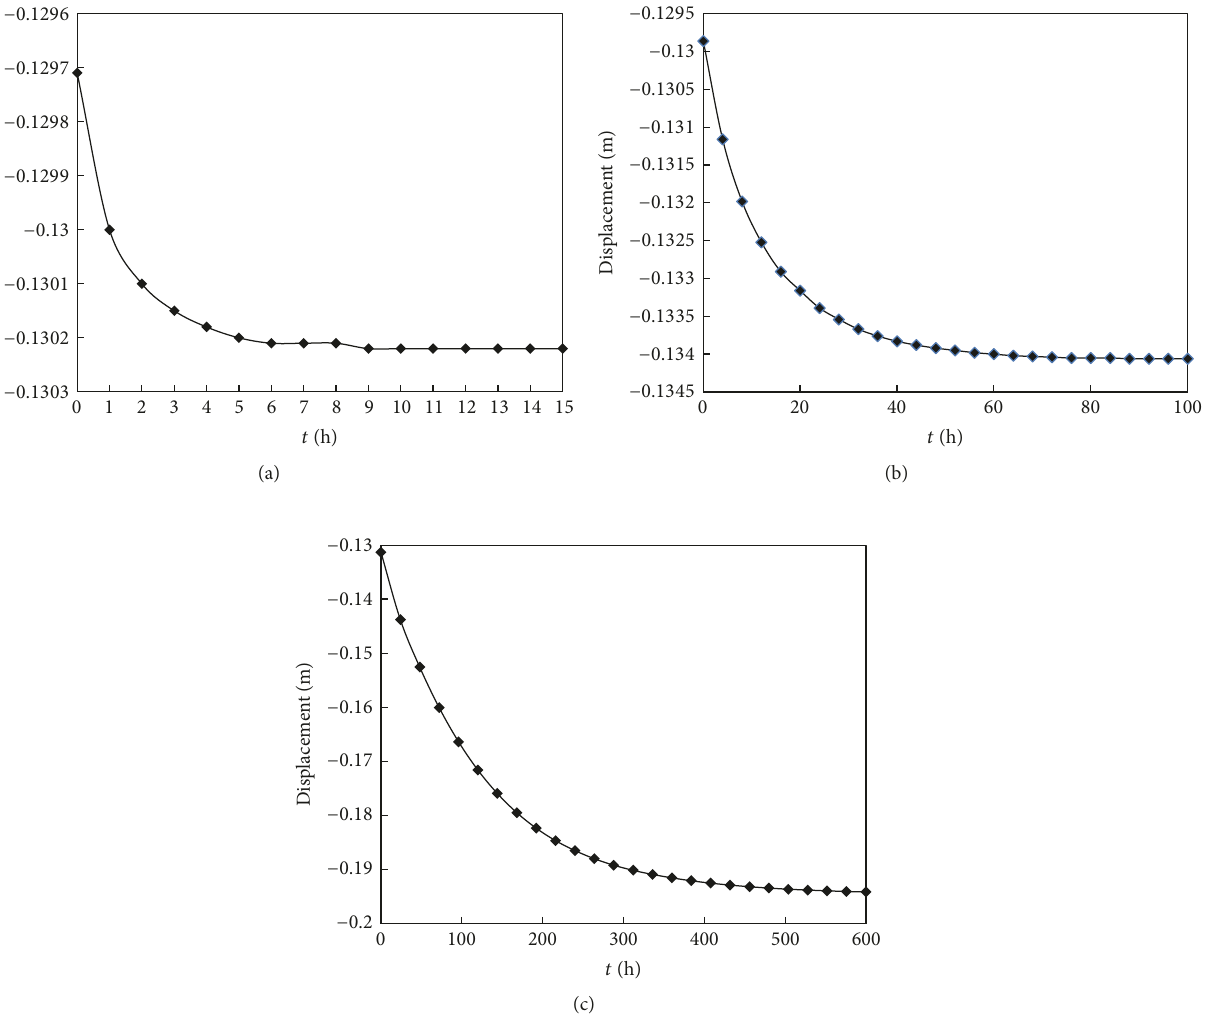
Figure 8: Settlement of point 0 in the model: (a) 𝑘 𝑠 = 1 × 10 −4 m/s; (b) 𝑘 𝑠 = 1 × 10 −5 m/s; (c) 𝑘 𝑠 = 1 × 10 −6